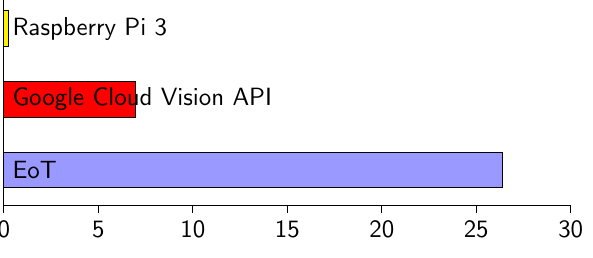
Figure 27. Efficiency for the task of face emotion recognition, in